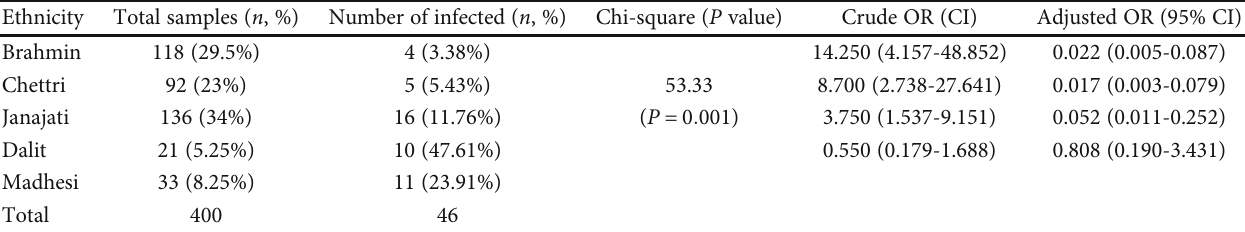
Table 4: Ethnicity-wise distribution of parasitic